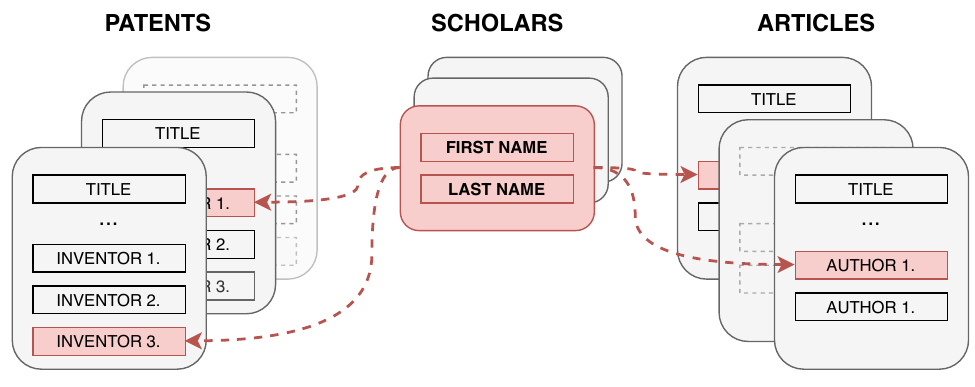
Figure 1. Linking patent inventors and authors of scientific